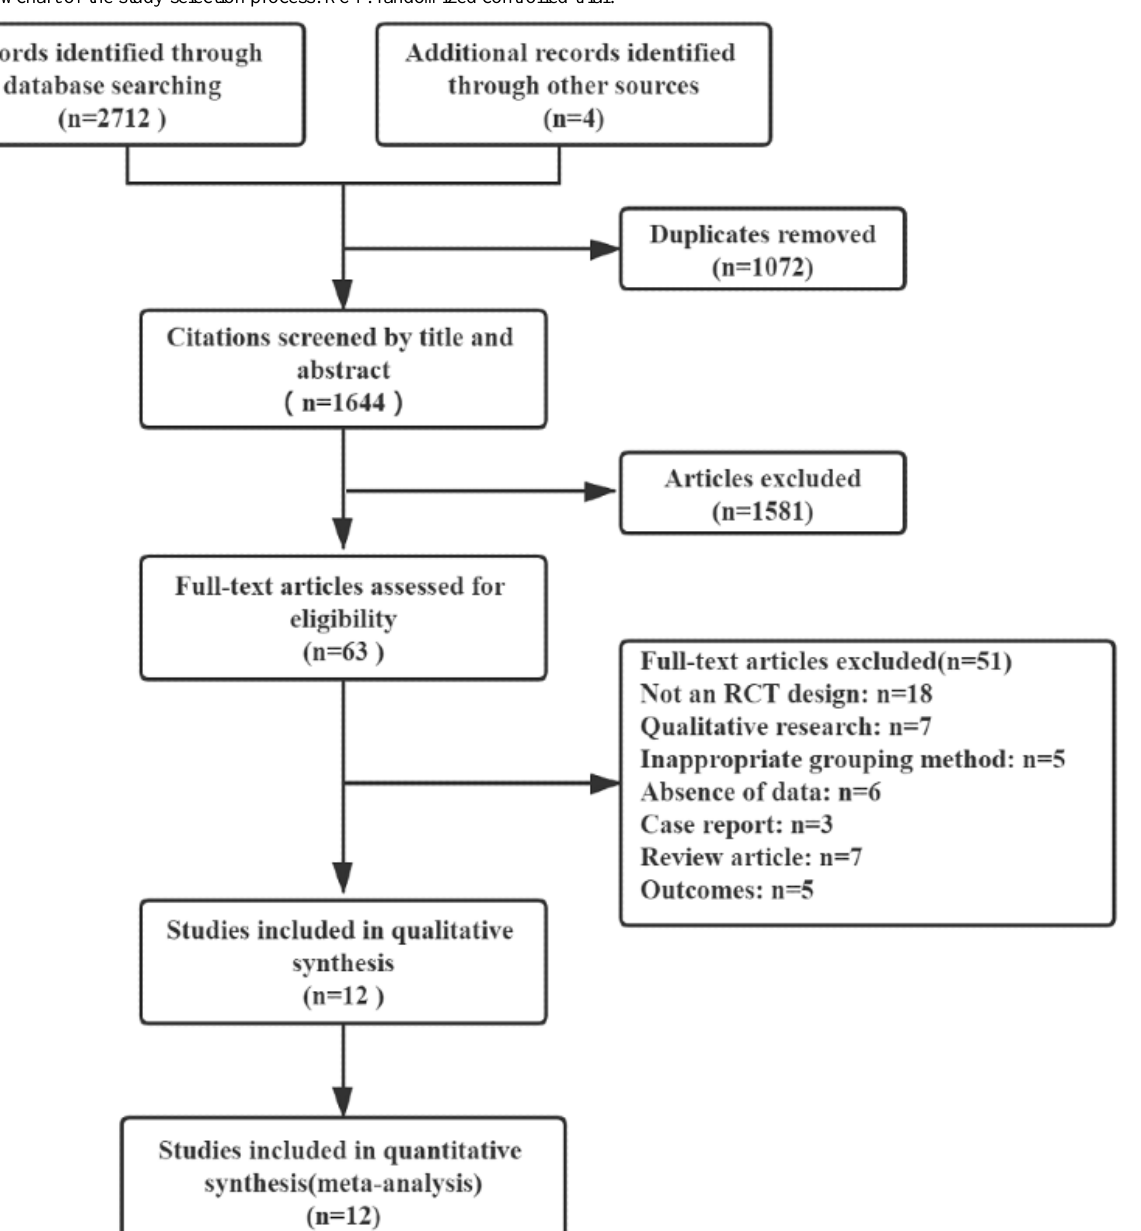
Figure 1. Flowchart of the study selection process. RCT: randomized controlled